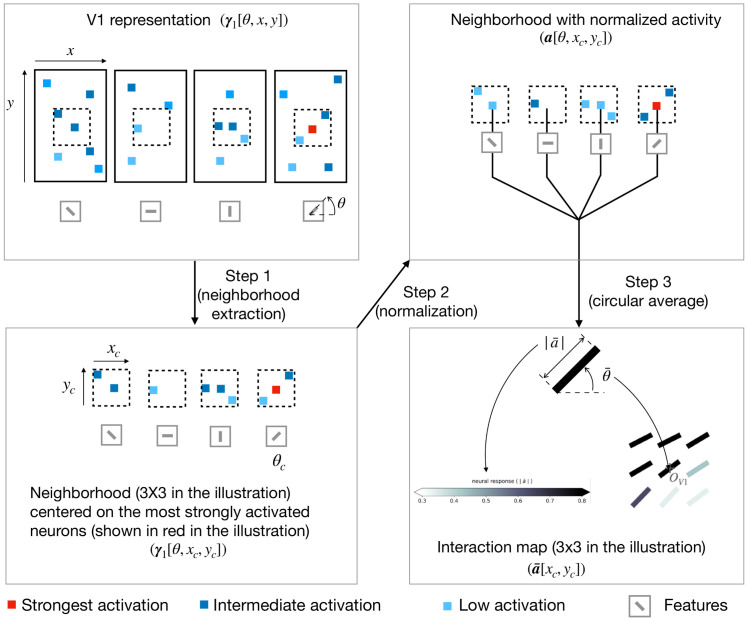
Illustration of the procedure to generate interaction map.In this illustrative example we consider a V1 representation with only 4 feature maps (represented in the upper-left box). Step 1 is to extract a neighborhood (of size 3x3 in the illustration only) around the most strongly activated neuron (represented with a red square in the illustration) for a given central preferred orientation (denoted θc). Step 2 is to normalize the neural activity in the extracted neighborhood using the marginal activity (see Eq 8). Step 3 is to compute the resulting orientation and activity at every position of the neighborhood using a circular mean (see Eqs 11 and 12 respectively). To keep a concise figure we have illustrated the computation of the central edge of the interaction map only. For simplification, the illustration shows only 1 neighborhood extraction whereas the interaction maps shown in the paper are computed by averaging neighborhoods centered on the 10 most strongly activated neurons.